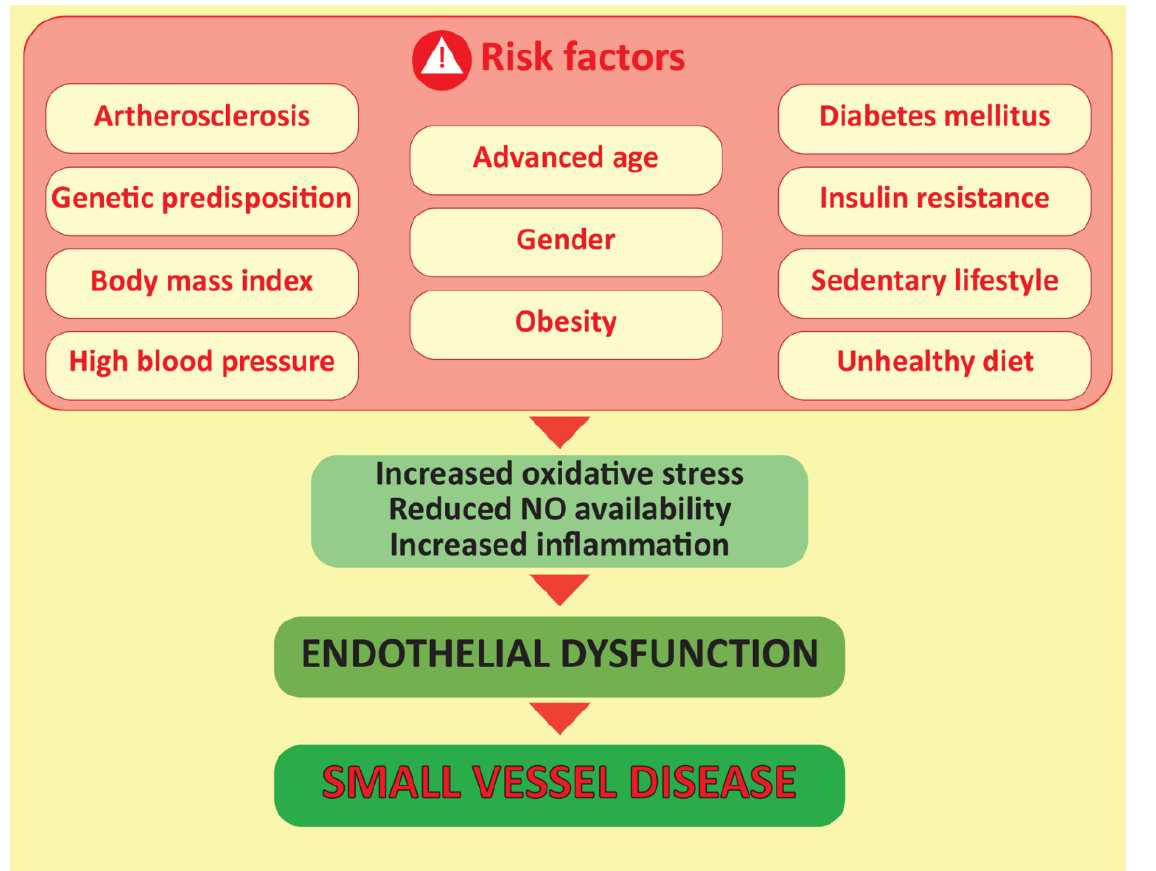
Figure 1. The figure describes the negative effects of a number of vascular risk factors that cause oxidative stress, reduced nitric-oxide (NO) production and the promotion of an inflammatory state that later leads to endothelial dysfunction underlying small-vessel disease. NO, nitric oxide. It is important to emphasize that, due to the aging of the population, it has recently been noticed that SVD affects the heart and brain more often [3,4]. Unfortunately, there is limited data and very little knowledge on this subject. For example, the epidemiology of large blood vessels and the effect on various organs has been thoroughly researched and documented, while the epidemiology of SVD and its consequences on the heart [3] and on the brain [4–6] is less well established. After 2003, many clinical reports began to pay special attention to SVD, which led to an exchange of experiences between experts and the implementation of joint research projects and successful therapies.